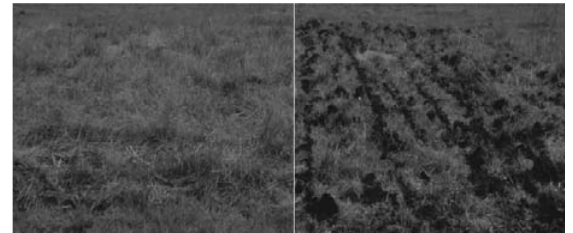
Figura 1. Vista detalhada da superfície do solo nos tratamentos de preparo, imediatamente após sua implantação, antes da realização do primeiro teste de erosão com chuva simulada (obs.: a imagem da esquerda corresponde à semeadura direta e a da direita à